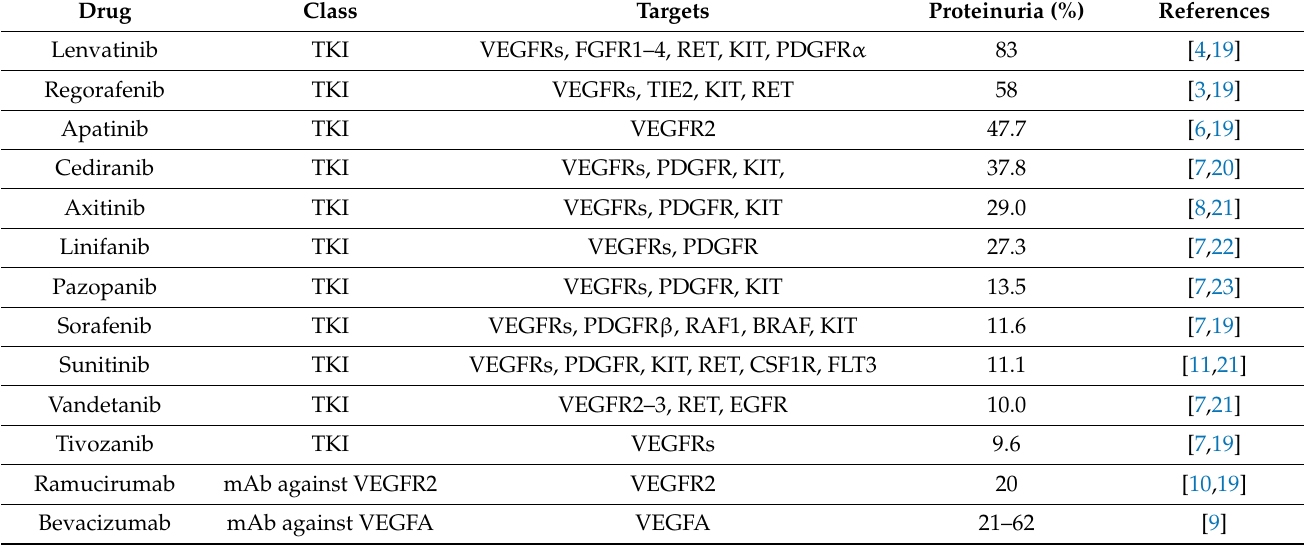
Table 1. The incidence of VEGF inhibitor-related